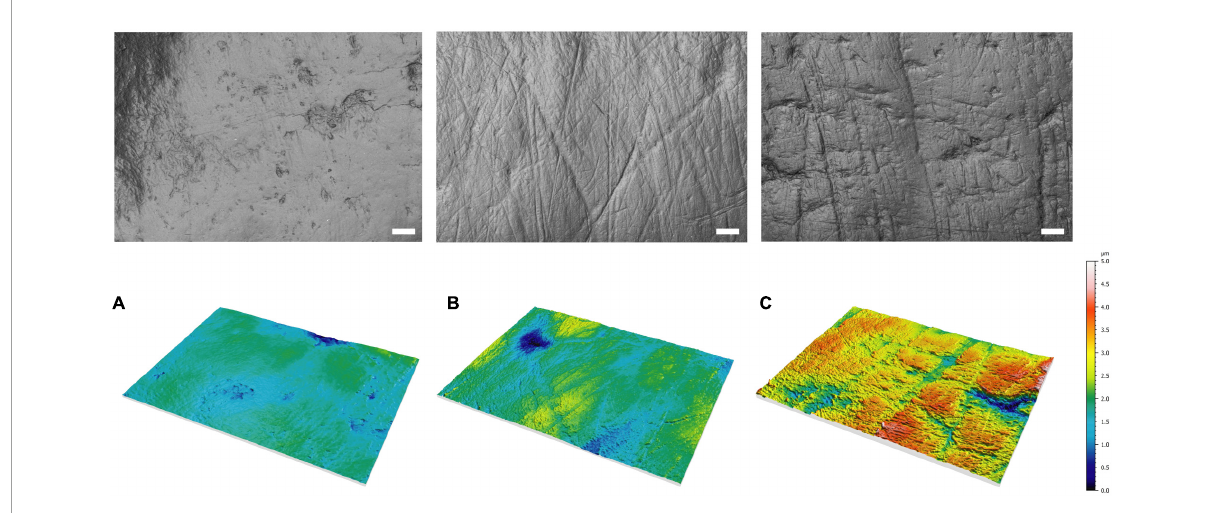
FIGURE3 Representative microwear 2D images and 3D models of tooth surfaces of Torihama deer [specimen number (A) FTS084-086, (B) FTS084-096, (C) FTS084-054]. Enamel prism structures can be observed in (A) . (B,C) Show show scratches. We also plotted the principal component scores of these specimens in Figure 4 . White bars in the 2D micrographs are 10 µ